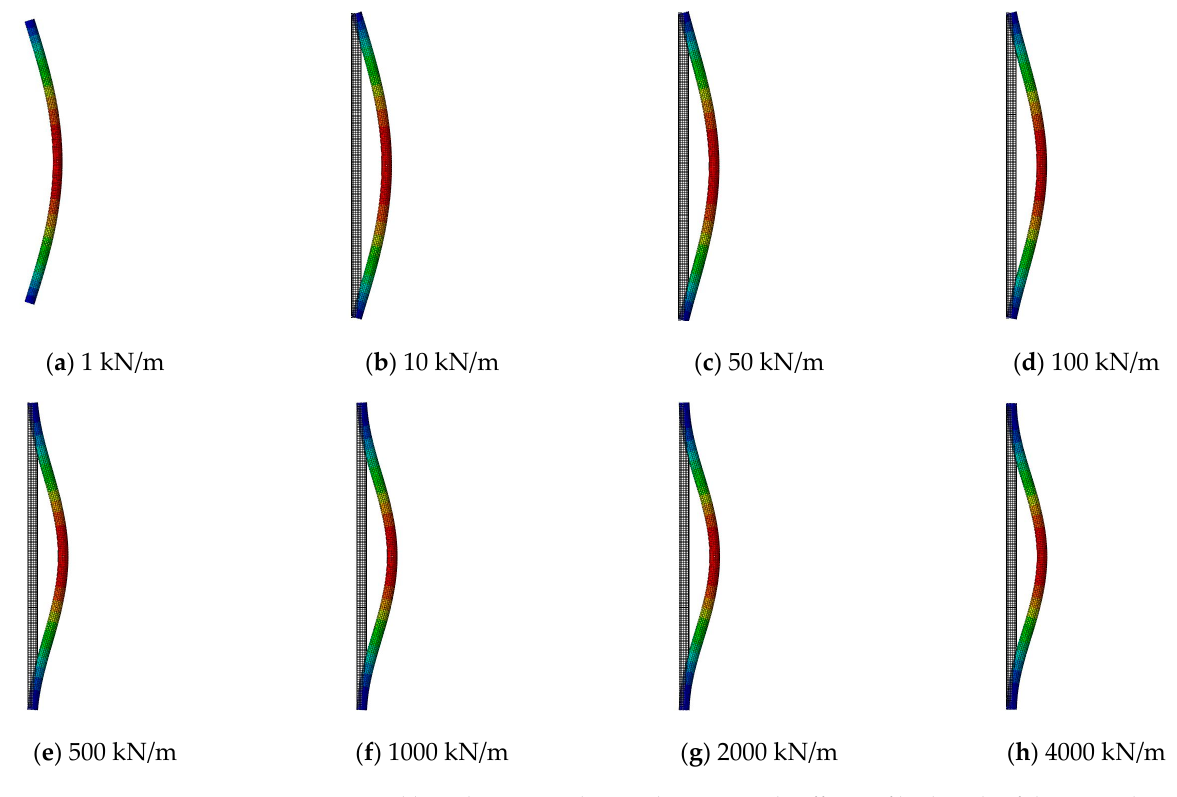
Figure 8. Buckling shape according to the rotational stiffness of both ends of the vertical member.